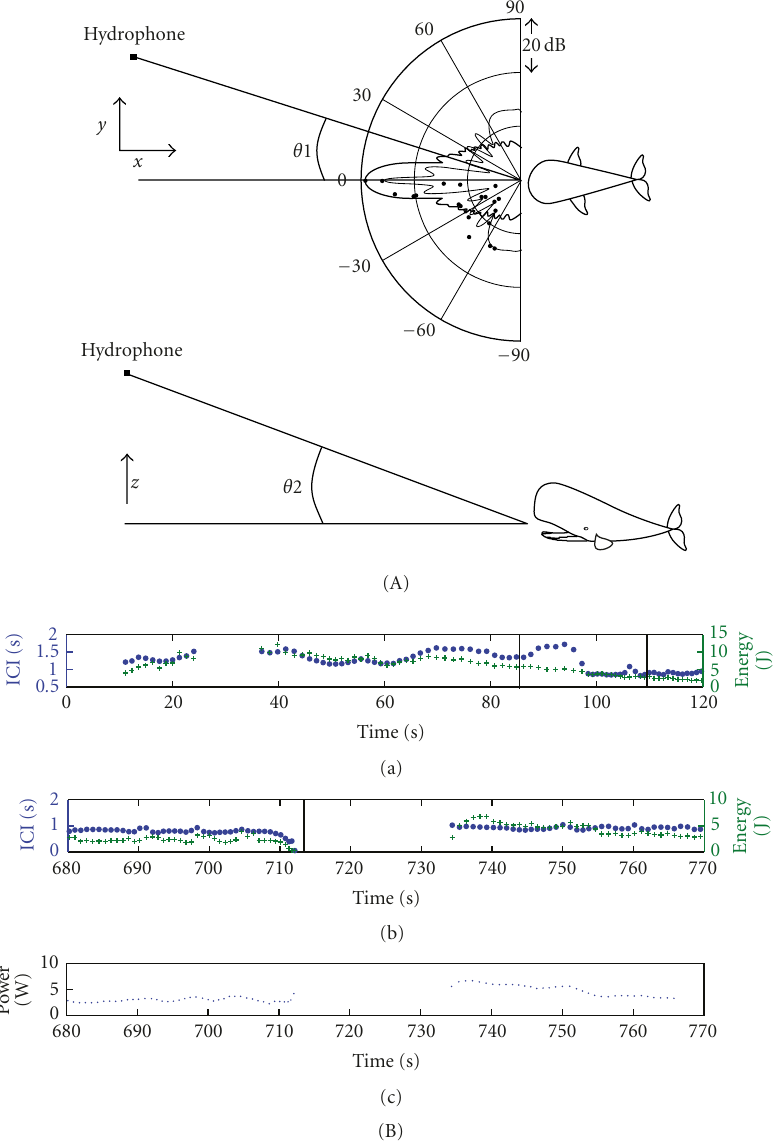
Figure 5: (A) Theta angles of a sperm whale. (B) Time zooms on ICI Figure 4(b) ( · ) and energy (+) on a foraging (a) and a prey attack (b) behavior (silence after the ICI inferior or equal to 0.45 s is due to ingestion). The variation between ICI min ,ICI max emphasizes a foraging behavior. In (a), during the first and the third phases between vertical lines, we can see a high correlation between energy (E) and ICI, respectively, 0.82 and 0.75, which means that pitch and yaw do not a ff ect the ICI and the energy with a possible power estimation, whereas in the second phase, correlation is 0.47, and the whale is pitching and/or yawing. In (b) the first phase also denotes a good correlation (0.77), and in the second the correlation decreases and also emphasizes a behavior change. (c) is the train click power versus time averaged on